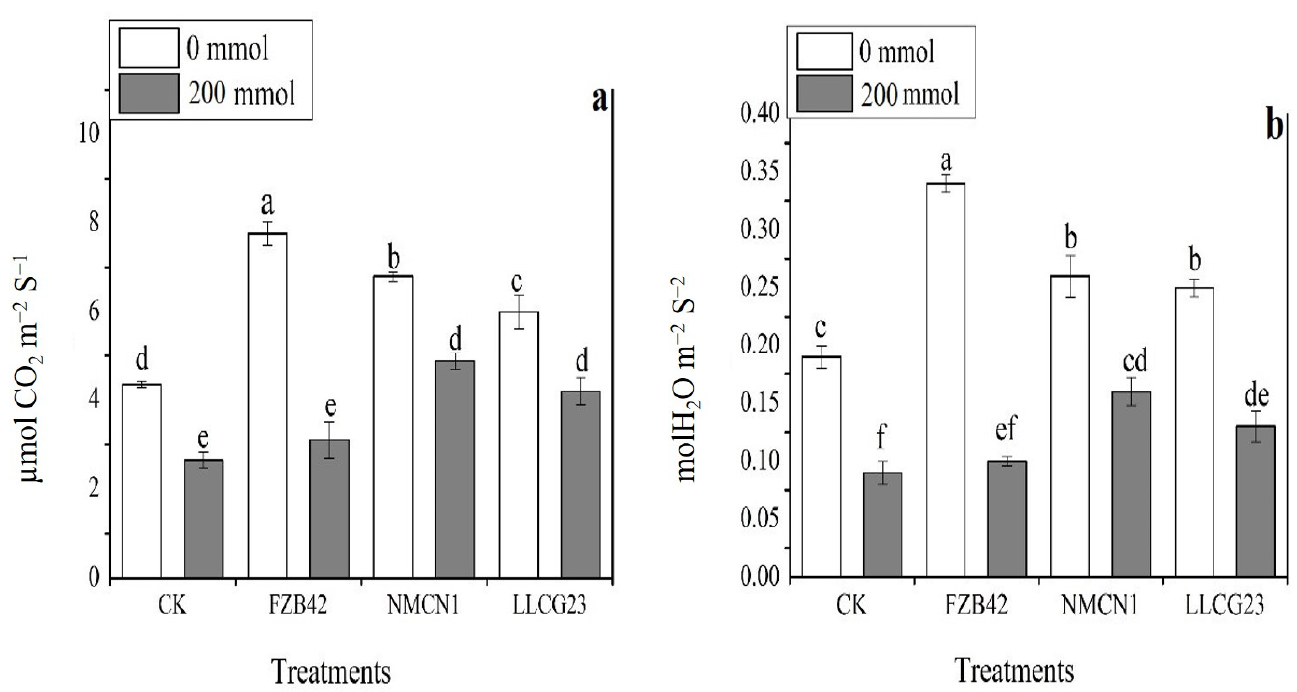
Figure 10. Effect of bacterial strains on photosynthesis rate and stomatal conductance regulation under salt stress. ( a ) Photosynthesis regulation of wheat plants inoculated with Bacillus strains under saline conditions; ( b ) Bacillus strains effects on stomatal conductance of wheat plants under different saline environment. The error bars represent the mean standard deviation of each treatment ( n = 3). The small letters were used to show significant difference among the treatments calculated through Tukey’s HSD test at p ≤ 0.05. The experiment was performed in triplicate with similar re- sults.